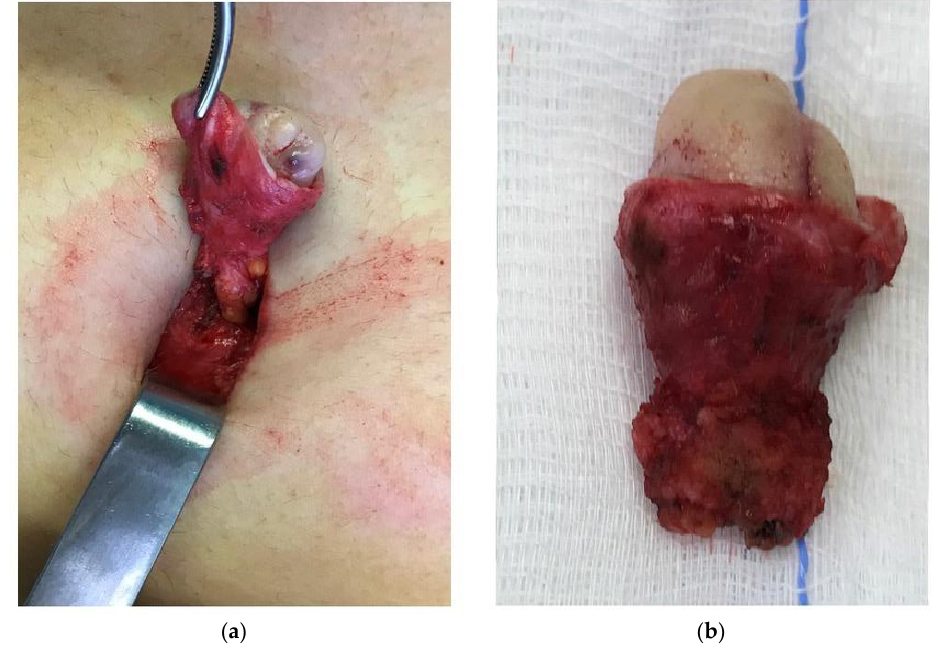
Figure 3. The umbilical peduncle is dissected down to the parietal peritoneum, which is included in the resected tissue ( a ). Anatomical specimen of en-bloc resection of umbilical endometriosis from the skin aspect to the parietal peritoneum ( b